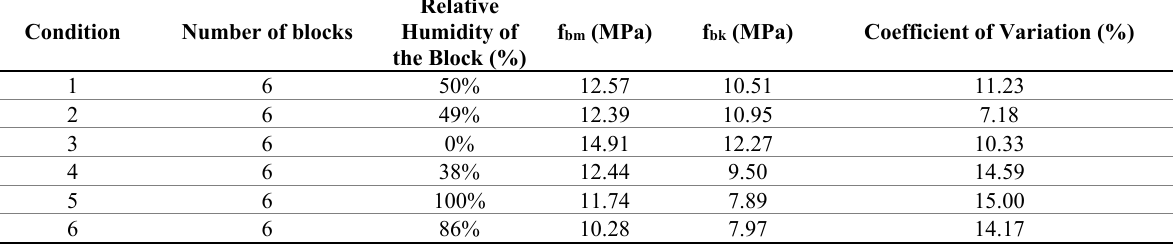
Table 4. Results obtained for group C blocks.